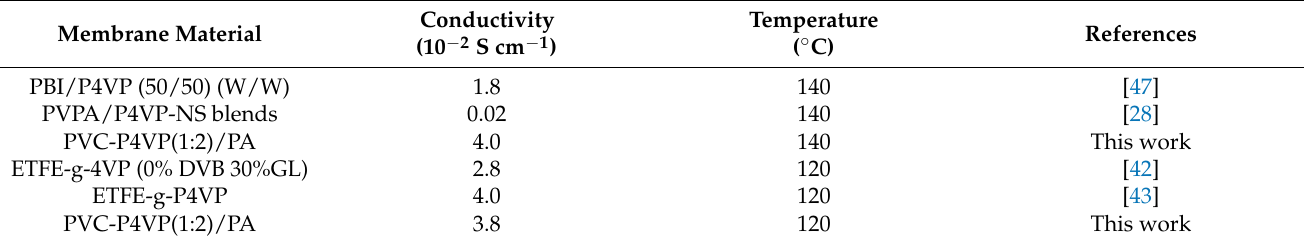
Figure 5. ( a ) Phosphoric acid doping rate of PVC-P4VP (1:X) after immersion in concentrated phos- phoric acid, ( b ) temperature dependence of proton conductivity on PVC-P4VP (1:X)/PA membranes, ( c ) effects of PVC/P4VP ratio on the proton conductivity at different temperatures and ( d ) stability of proton conductivity of PVC-P4VP (1:2)/PA membrane at 160 ◦ C. Table 1. Comparison of proton conductivity of PVC-P4VP(1:2)/PA membrane with reported mem- branes at high